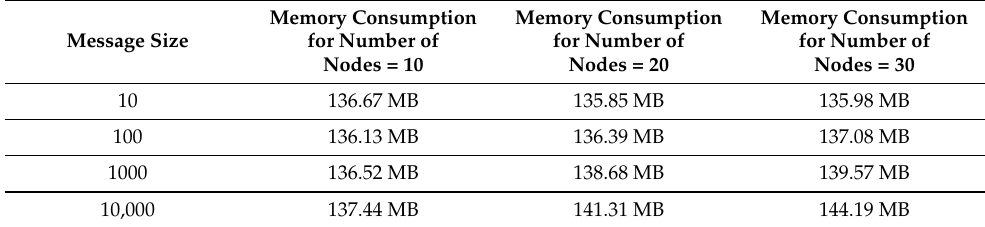
Figure 6. Execution time vs. message size. Table 4. Comparison between memory consumption and message size.